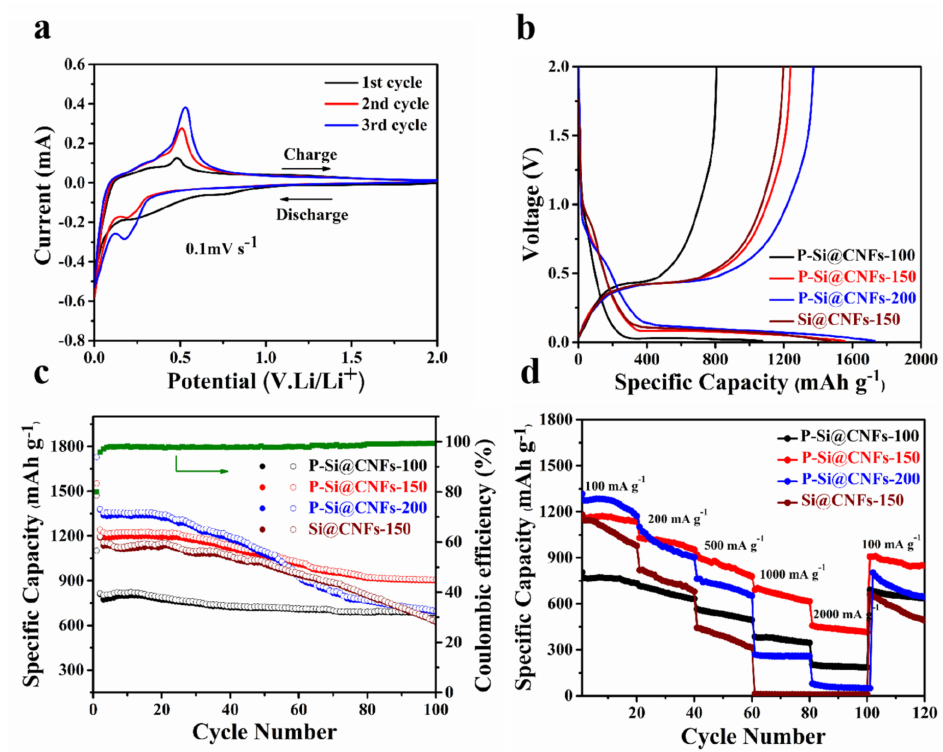
Figure 4. Electrochemical properties: CV profiles of P − Si@CNFs − 150 ( a ), discharge/charge curves ( b ), cycle life of P − Si@CNF samples and Si@CNFs − 150 at a current density of 100 mA g − 1 and Coulombic efficiency of P − Si@CNFs − 150 ( c ), and rate performances of P − Si@CNF samples and Si@CNFs − 150 ( d